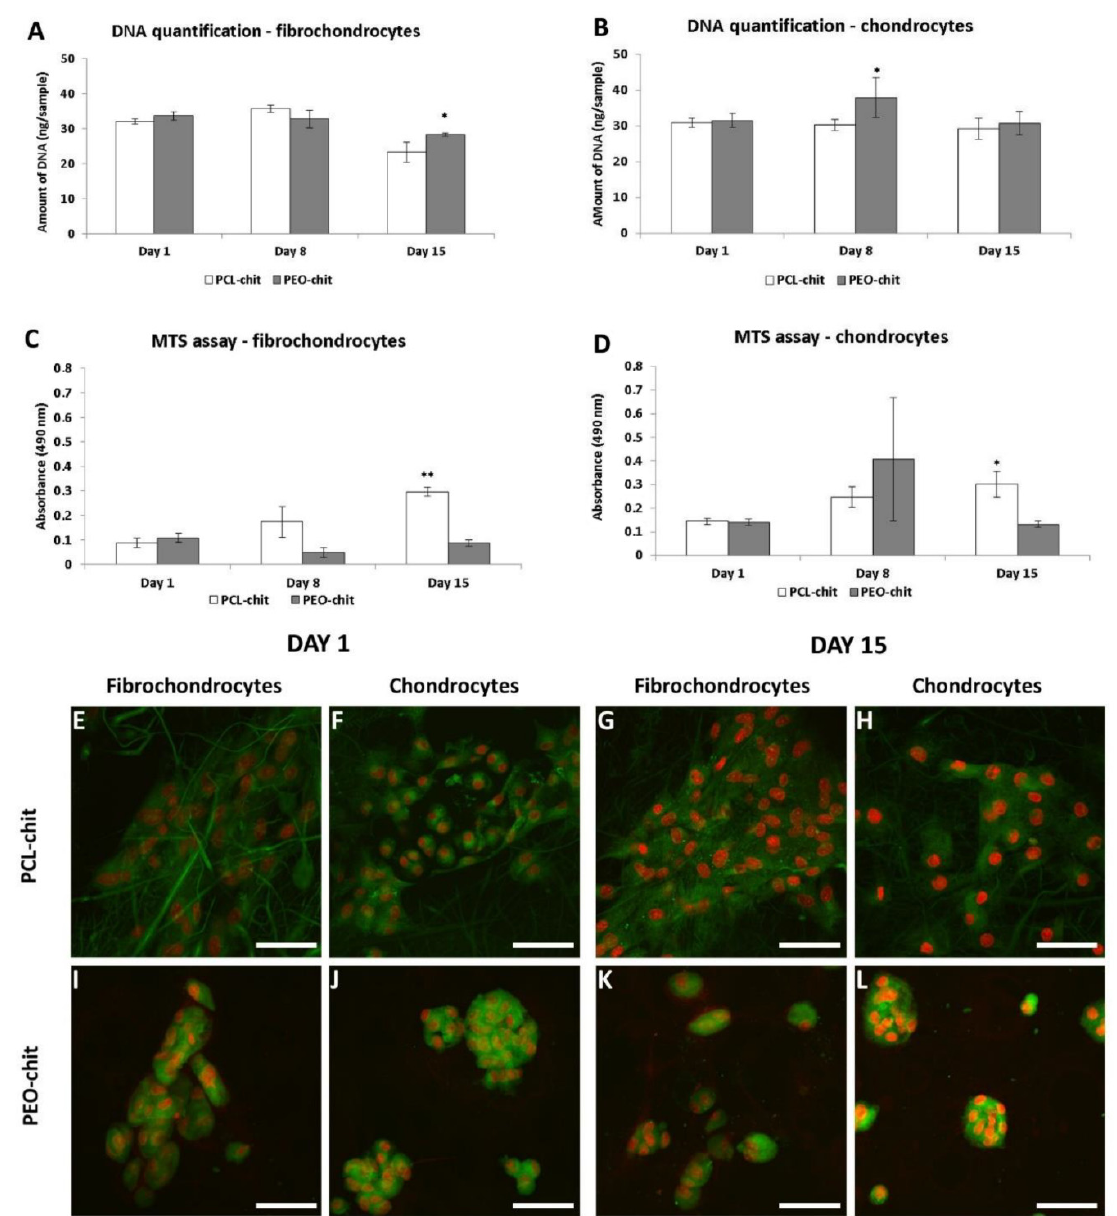
Figure 3. DNA quantification ( A , B ) and metabolic activity, measured by MTS assay ( C , D ) and visualization of fibrochondrocyte and chondrocytesadhesion and distribution on PCL-chit and PEO-chit sca ff olds on days 1 and 15 using a confocal microscope ( E – L ). The values were compared statistically between the samples on the same day. Cell nuclei were stained using propidium iodide (red color) and cell internal membranes using DiOC3 (green color). Magnification: 600 × ; scale bar: 50 µ m. Data are shown as mean ± standard deviation, * p < 0.05 and ** p < 0.001.